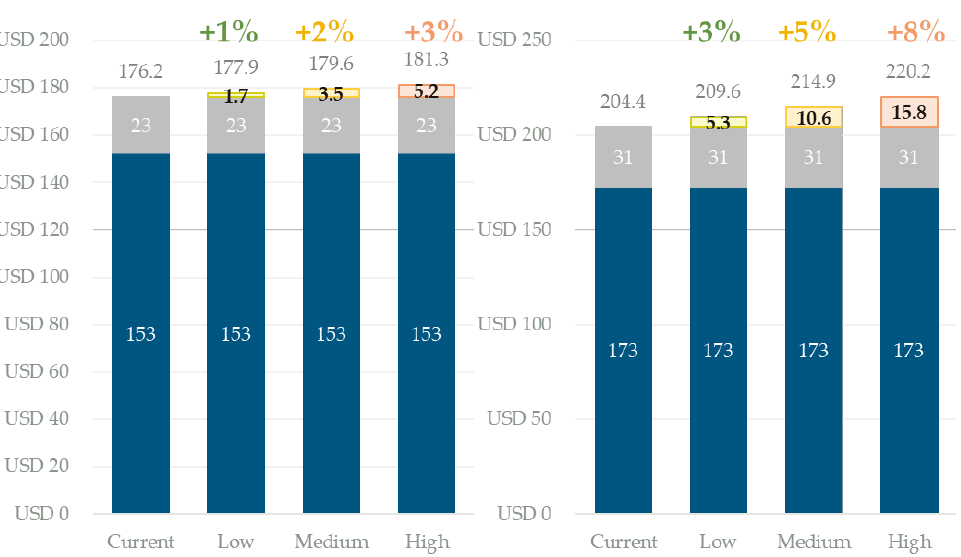
Figure 9. The impact of the carbon tax under various charging levels on trading prices for coal imports ( Left : Australia, Right : South Africa). Notes: In October 2021, the average freight rates for coal from Australia and South Africa to China were 23.37 USD/ton (Newcastle – Zhoushan) and 31.37 USD/ton (Richards – Qingdao). The average trading prices of coal were traded at an estimated 152.78 USD/ton and 172.99 USD/ton. Source: Shanghai Shipping Exchange.